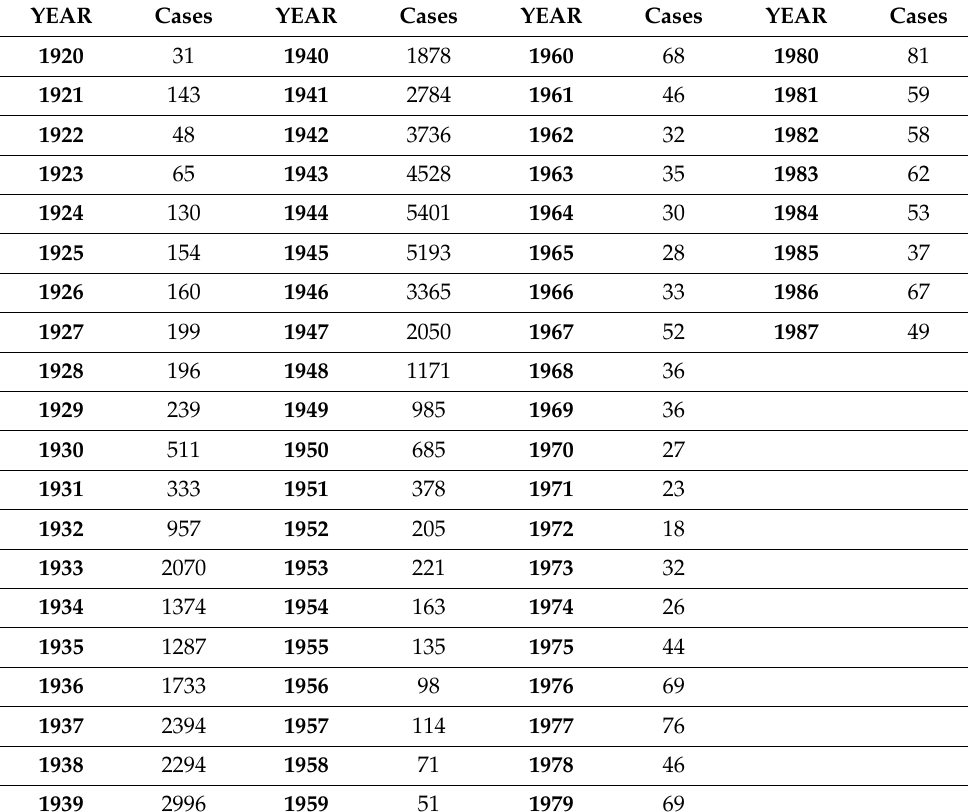
Table 1. Reported Cases of Flea-Borne Typhus the United States, 1920–1987 a,b,c